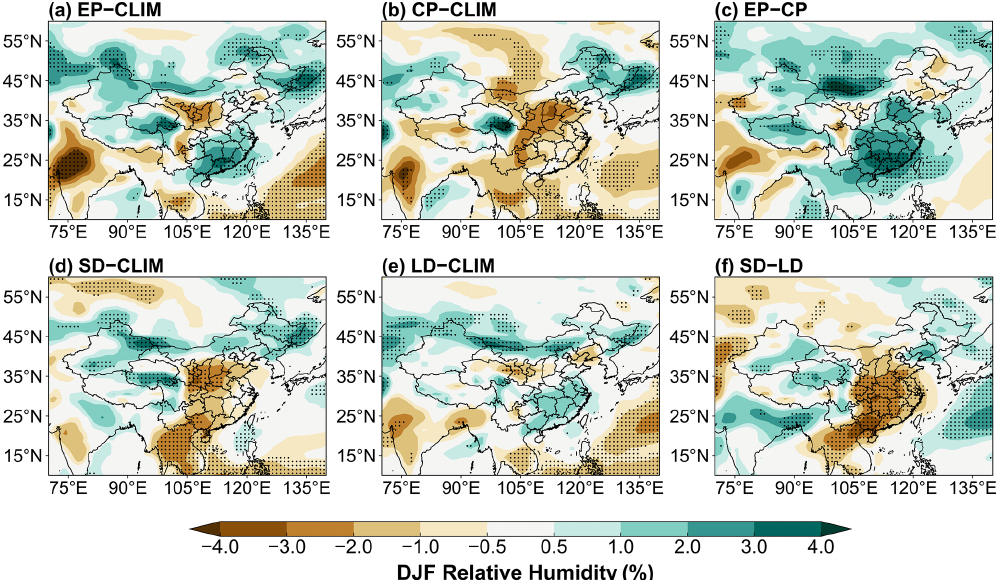
Figure 6. Composite differences in DJF mean relative humidity (%) between EP and CLIM in (a) , CP and CLIM in (b) , EP and CP in (c) , SD and CLIM in (d) , LD and CLIM in (e) , and SD and LD in (f) . The stippled areas indicate statistical significance with 90% confidence from a two-tailed t test.